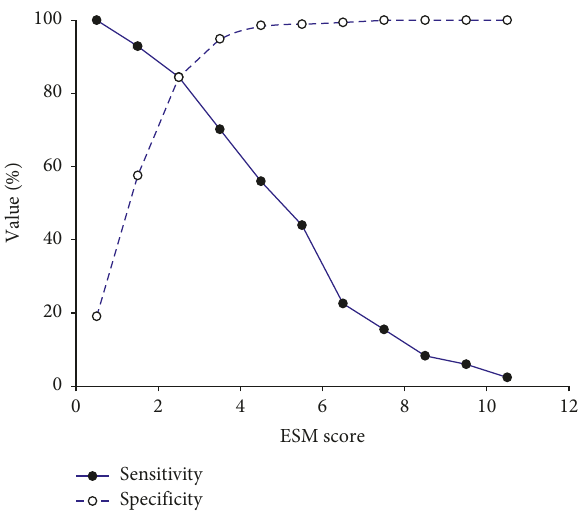
Figure 2: Cutoff point of ESM score to predict postoperative mortality. ESM: emergency surgery mortality. Table 5: Performance of ESM score ≥ 4 to predict postoperative mortality in Training and Validation groups.